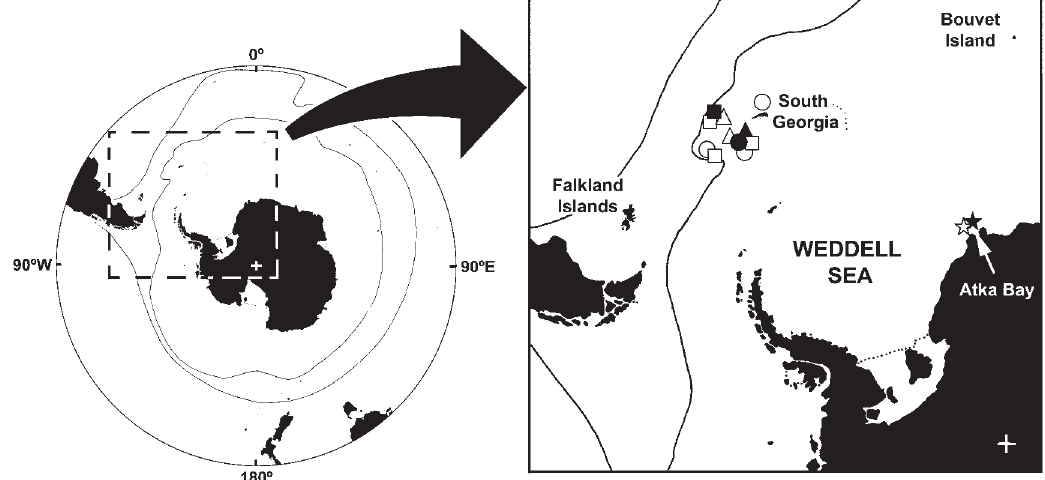
Fig . 1. – Known distribution of Thouarella species described in this paper: triangle, Thouarella bayeri n. sp.; circle, Thoaurella sardana n. sp.; square, Thouarella undulata n. sp.; star, Thouarella andeep n. sp. Solid symbols represent the respective type